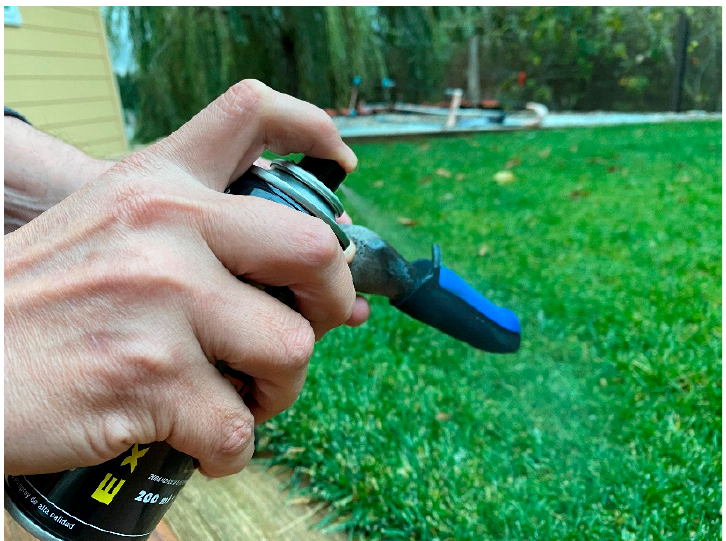
Figure 8. Spray application.